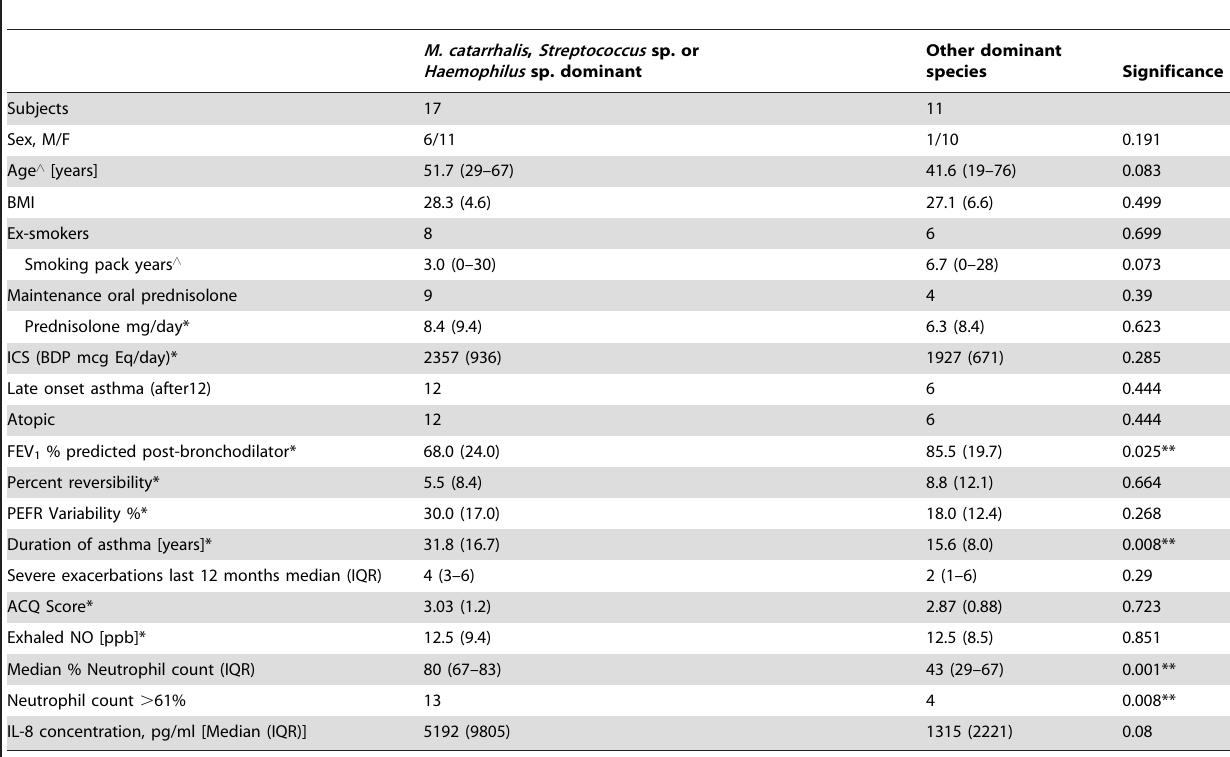
Table 1. Clinical, physiologic and airway inflammation characteristics for subjects with either Haemophilus sp., Streptococcus sp. , or M. catarrhalis as the most dominant airway species, and subjects with other dominant